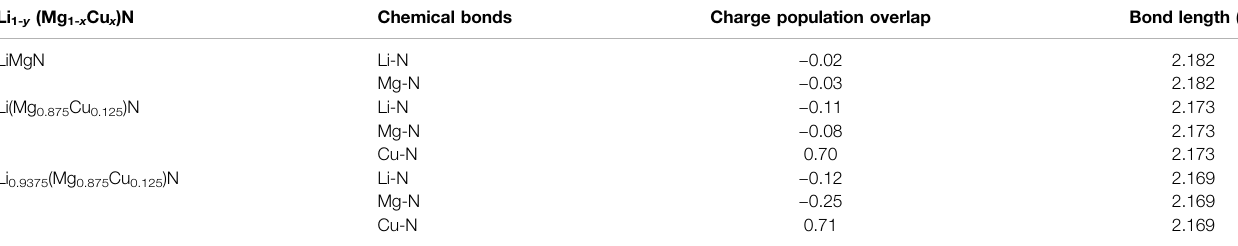
TABLE 3 | The charge population overlap and bond length of the chemical bonds for Li 1-y (Mg 1-x Cu x )N.